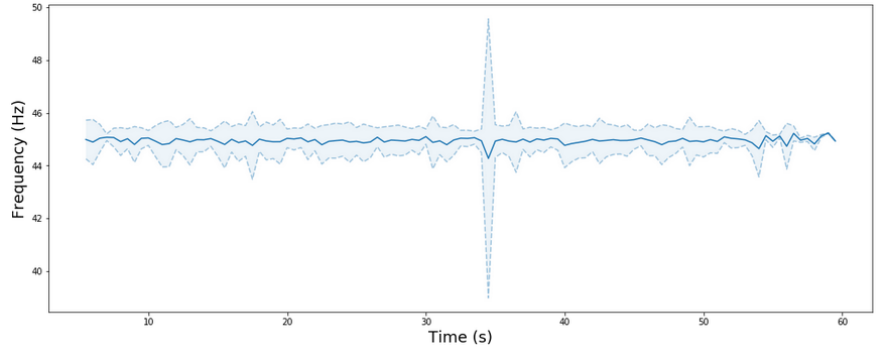
Figure 3. Temporal evolution of the eye tracking (ET) data frequency. The blue line is the average frequency by subject for each second. The discontinuous line indicates the standard deviation above and below the mean